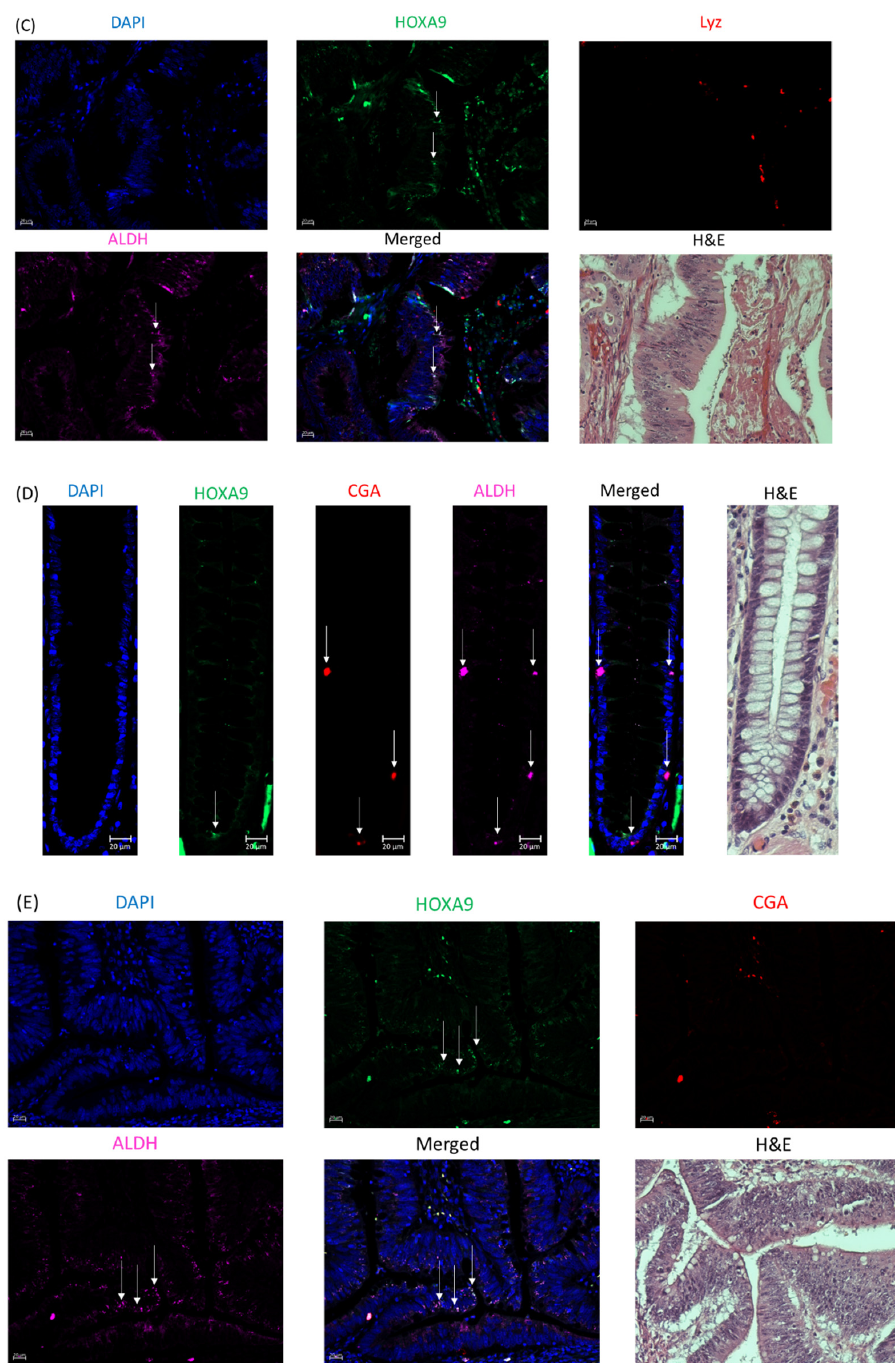
Figure 4. HOXA9 protein is selectively expressed in ALDH+ colonic SCs and is overexpressed in CRCs. ( A ) Images of normal and tumor colon tissue stained for HOXA9. Normal tissue is at 10 × magnification, and tumor tissue is at 20 × magnification. The tumor shown is a stage 2A adenocarcinoma of the ascending colon. IF staining was performed on normal and tumor tissues ( B , C ) that were also co-stained for HOXA9 (green), lysozyme (red), and ALDH (magenta). The tumor shown is a stage 2A mucinous adenocarcinoma of the descending colon. IF images are also shown of normal and tumor colon tissues ( D , E ) that were co-stained for HOXA9 (green), CGA (red), and ALDH (magenta). The tumor shown is a stage 1 mucinous adenocarcinoma in the ascending colon. Arrows point to ALDH+ cells. All IF images are at 20 × magnification. Separate hematoxylin and eosin (H&E) slides are included to show the general tissue structure in matching IF